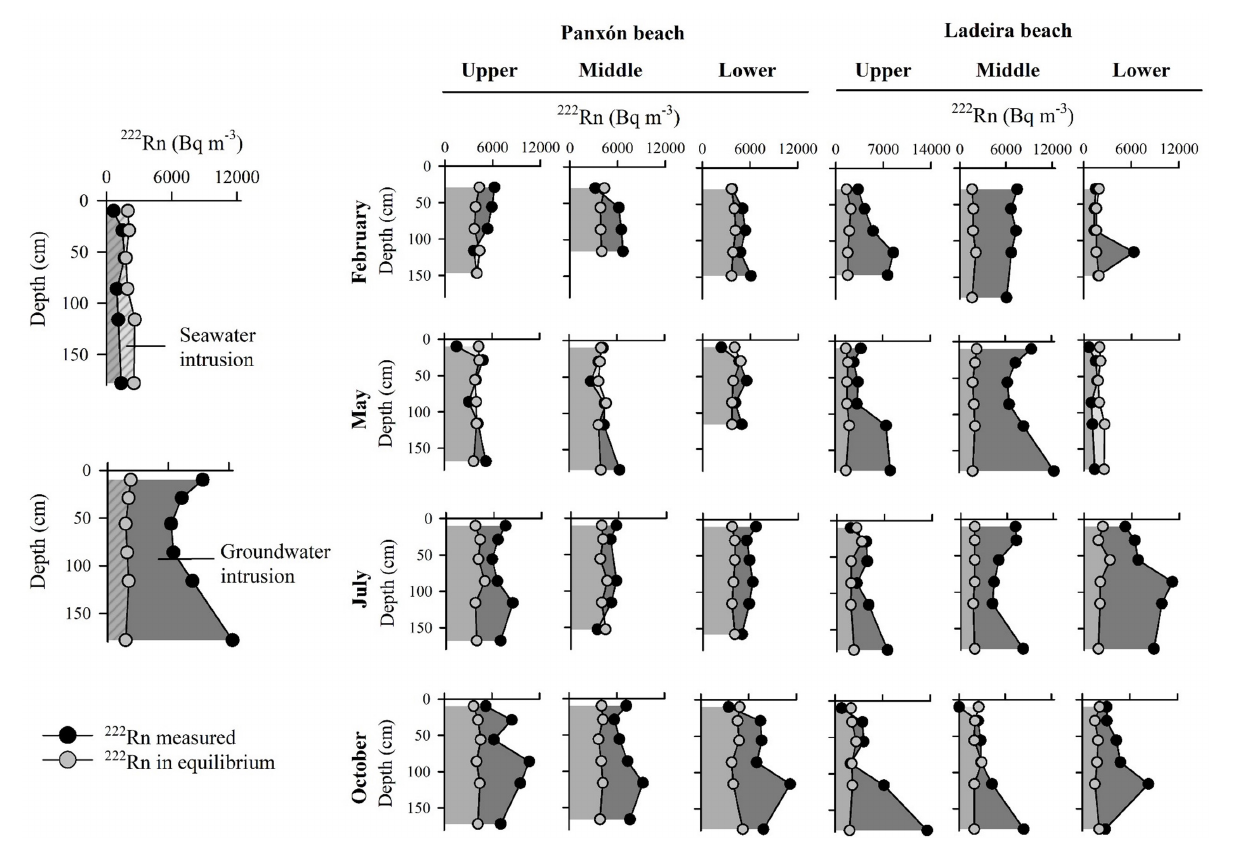
FIGURE 7 | Measured porewater 222 Rn activities (black) and equilibrium 222 Rn activities (those produced by the sediment in equilibrium + 226 Ra activities; gray) per month and beach. When measured 222 Rn activities are over the equilibrium activities it is considered an indication of continental groundwater intrusion (dark gray), and when equilibrium activities are higher than those measured, it is considered an indication of recent seawater intrusion (light